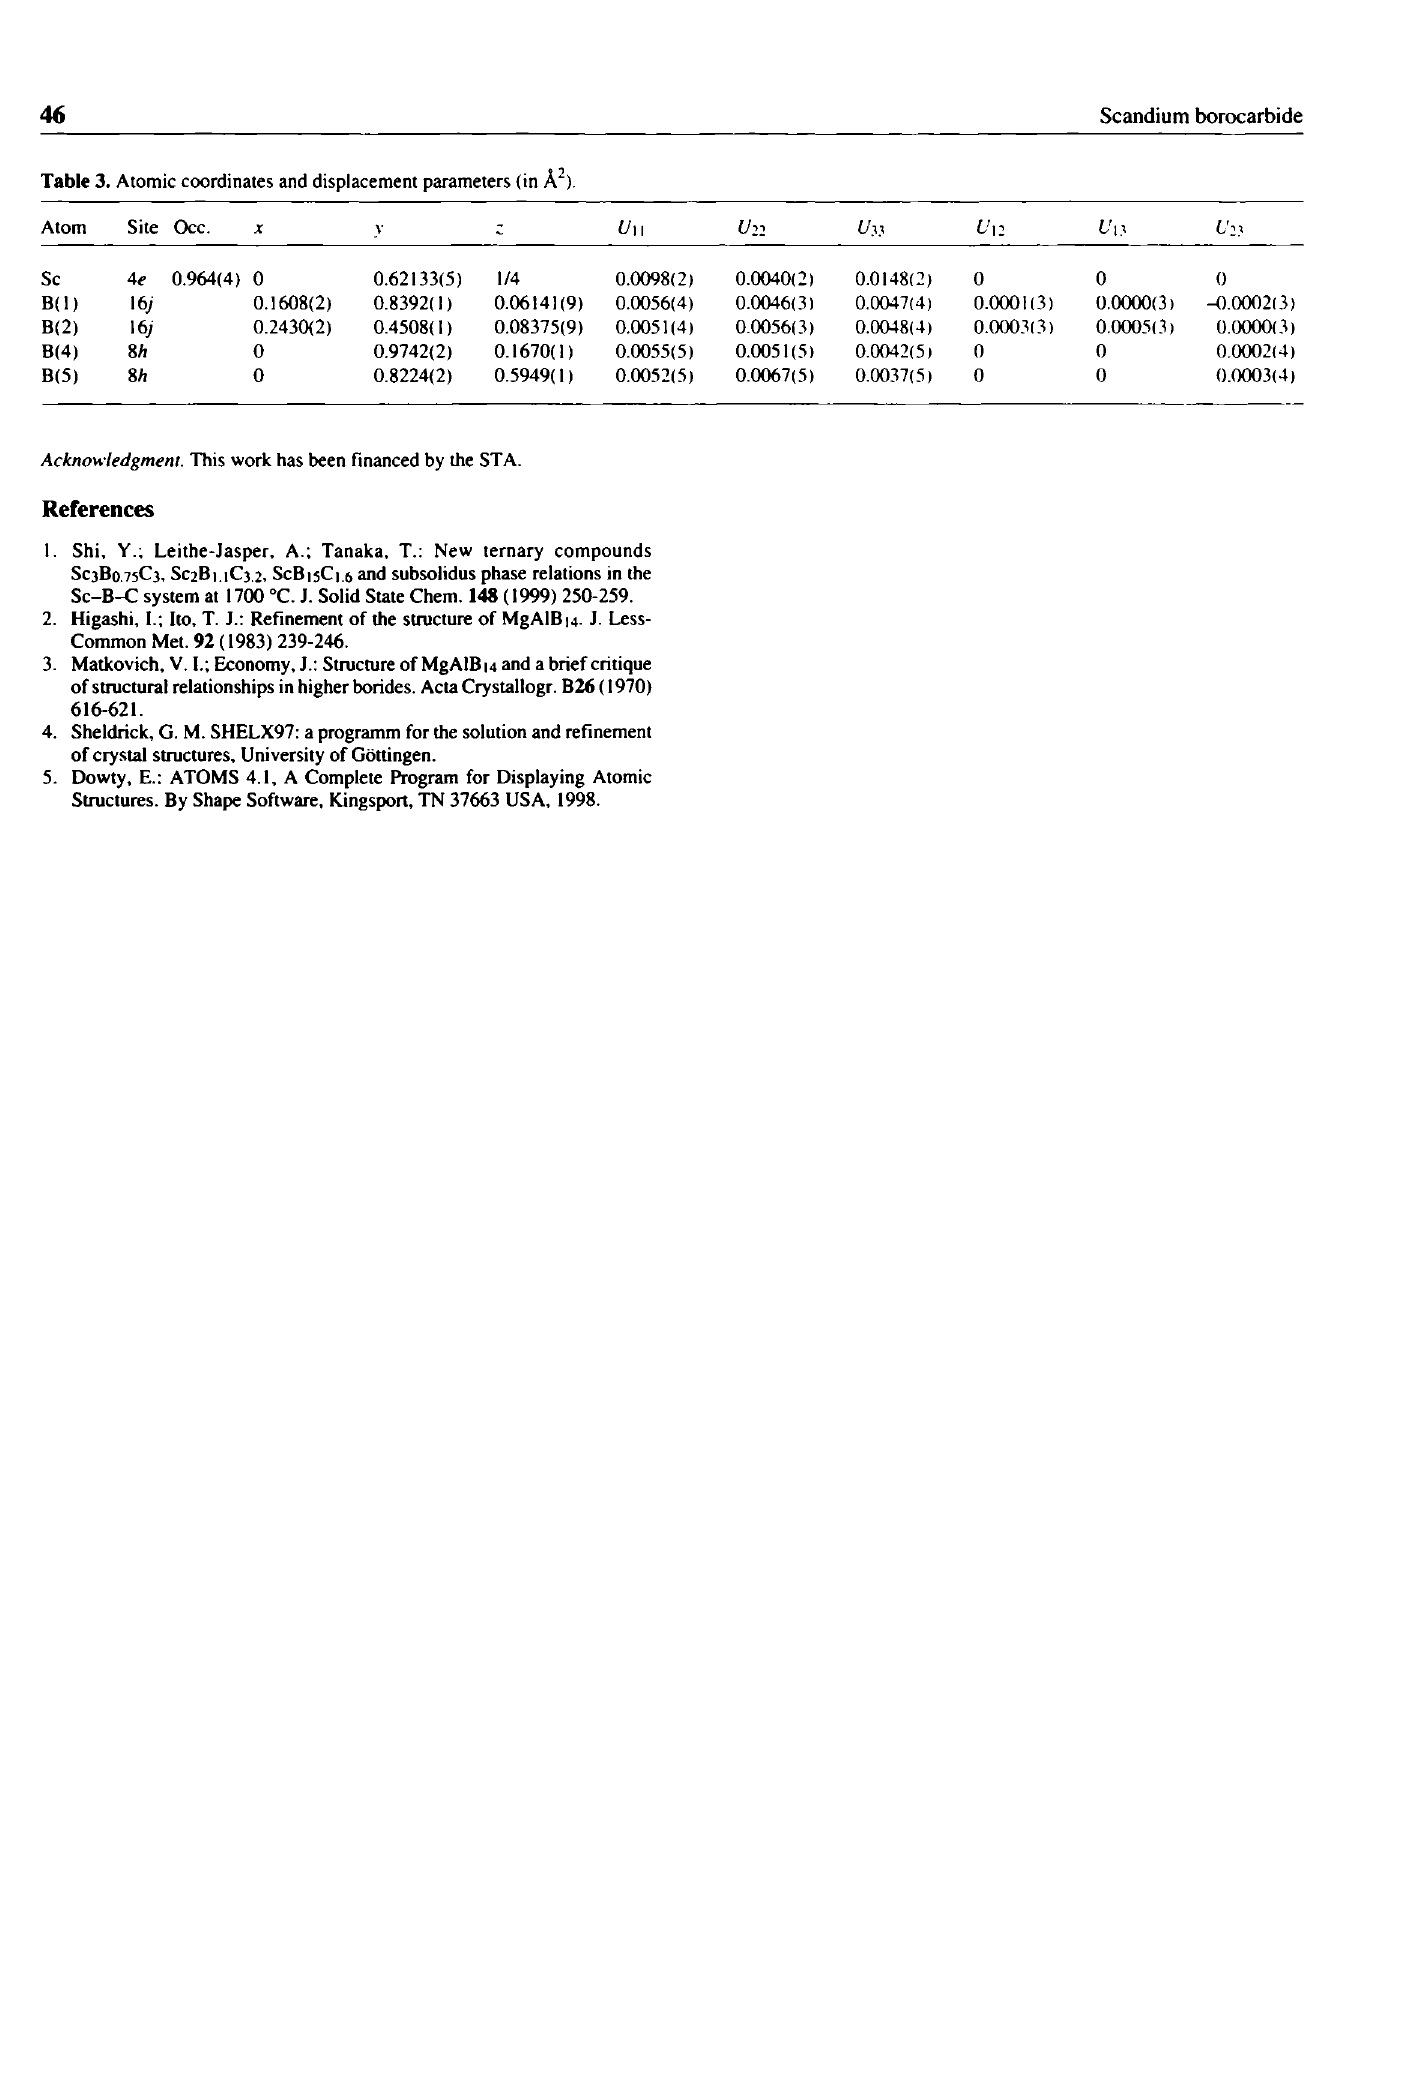
Table 3. Atomic coordinates and displacement parameters (in Ä 2 ). Atom Site Occ. Uu U 2